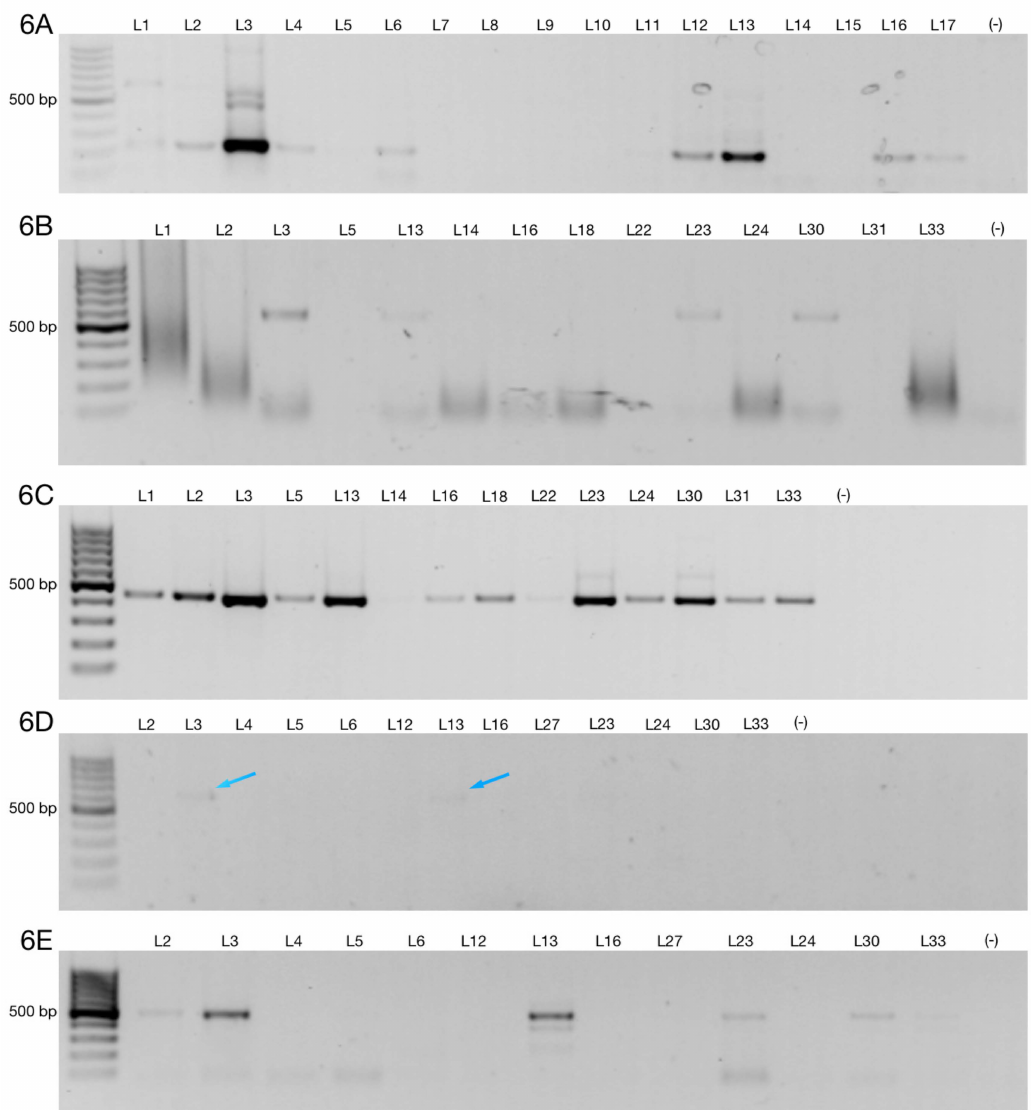
Figure 6. ZNF695 transcript variants are expressed in B-ALL patients. ( A ) Agarose gel showing the analysis of a representative sample expressing ZNF695_TV3. ( B ) Agarose gel showing samples with very low but positive expression of ZNF695_TV4. ( C ) Agarose gel showing samples positive for ZNF695_TV5 expression. ( D ) Expression of ZNF695_TV6 in B-ALL. We observed low expression of ZNF695_TV6 in some samples, as indicated by the blue arrows. ( E ) Expression of ZNF695_TV7 in